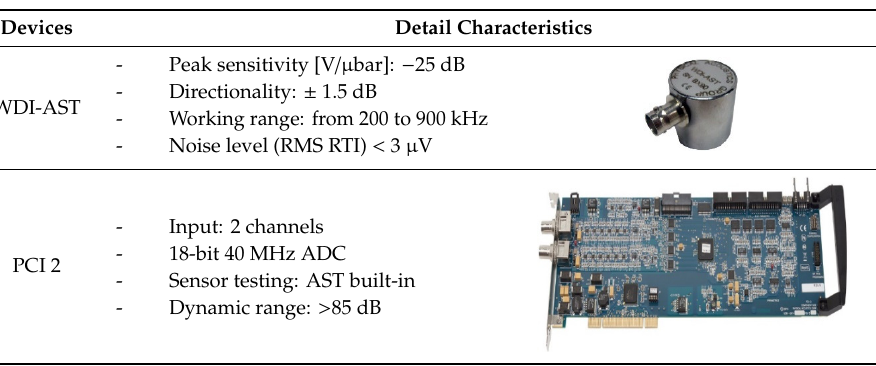
Table 1. Details of the data acquisition devices.